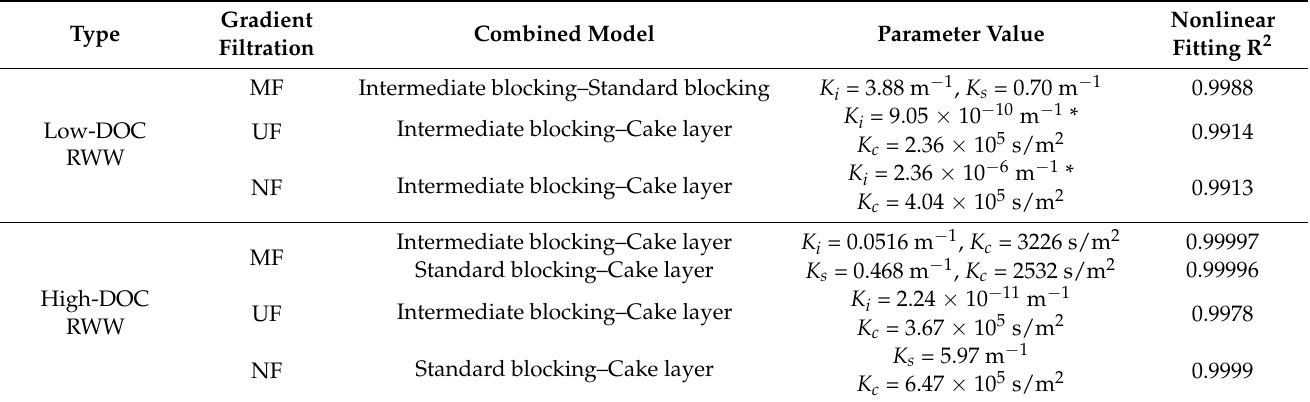
Table 5. Fitting results of combined models during gradient filtration of RWW.